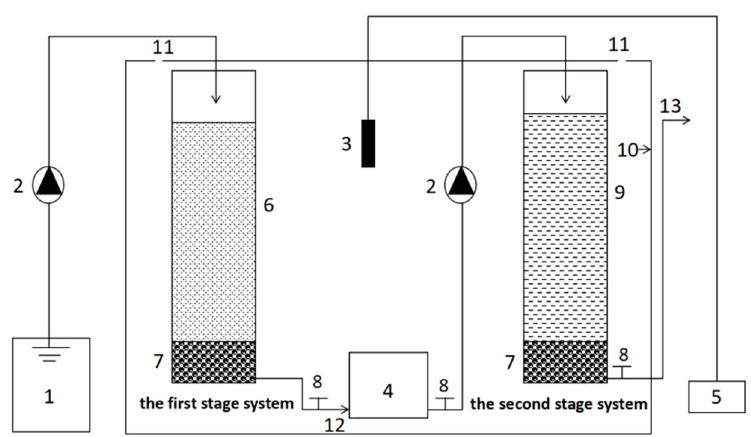
Figure 3. Schematic diagram of the simulated two-stage column CRI. 1: Feeding tank (V = 5 L); 2: Peristaltic pump; 3: Thermometer; 4: Tank to add a carbon source (V = 1 L); 5: Temperature controller; 6: Filling medium; 7: Support layer; 8: Valve; 9: Saturated section; 10: Insulation mantle; 11: Air hole;